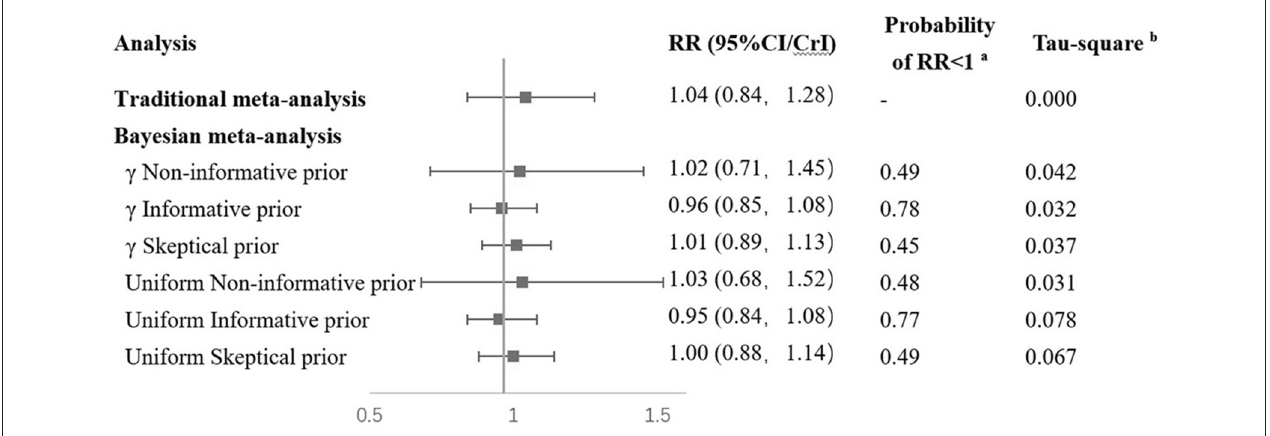
FIGURE 3 | Results of combination of RCTs and observational studies in Bayesian. a RR < 1 means that results favor Vitamin D supplementation. b Tau-square means between study variance. RCT, randomized controlled trial; RR, risk ratio; MD, mammography density. visual inspection for symmetry of funnel plot, with no evidence of publication bias observed ( p -values >